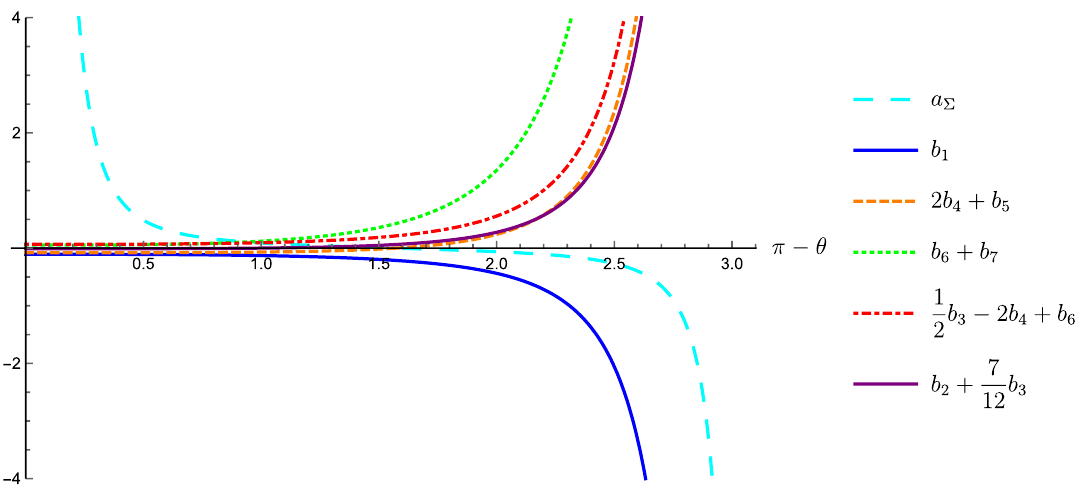
Figure 7 . Behavior of the (linear combinations of) boundary central charges computed via AdS/BCFT, in units of πL 4 /G N , as functions of the angle, π − θ , at which the end-of-the-world AdS brane intersects the AdS 6 boundary. The UV values of θ are on the left hand side of the figure, while the IR values are on the right. Note, though, that at all values of 0 ≤ θ ≤ π are